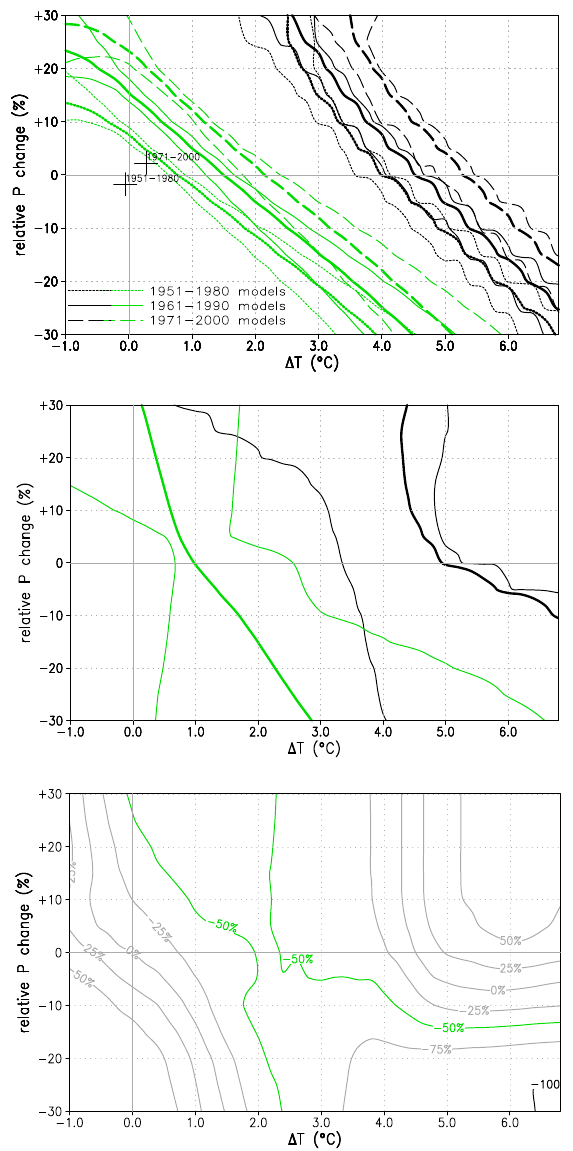
Fig. 4. Impact response surfaces showing the combinations of changes in annual mean temperature and precipitation for which half (green lines) and all (black lines) of the simulated palsa area be- comes unsuitable relative to the simulated distribution for the 1961– 1990 baseline period. The thicker lines show values for ensemble averages of: (a) GAM models calibrated for three different base- line periods (25 ensemble members each), with observed tempera- ture changes relative to 1961–1990 also shown (crosses); (b) ANN models calibrated for the 1961–1990 baseline period (11 ensemble members); (c) a single CTA ensemble member. The thinner lines show the range for the